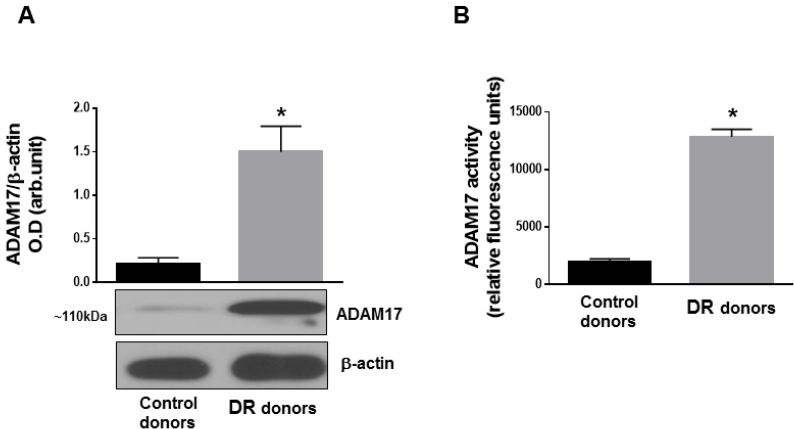
Figure 1. A disintegrin and metalloproteinase 17 (ADAM17) expression and activity in human postmortem retinal tissue. ( A ) Representative blots and densitometry analysis of ADAM17 expression and ( B ) ADAM17 enzymatic activity measured by fluorimetric assay in postmortem human retinas from normoglycemic (control) donors and donors with diabetic retinopathy (DR). Data presented as mean ± SE. * p < 0.01. n = 6 in each group.